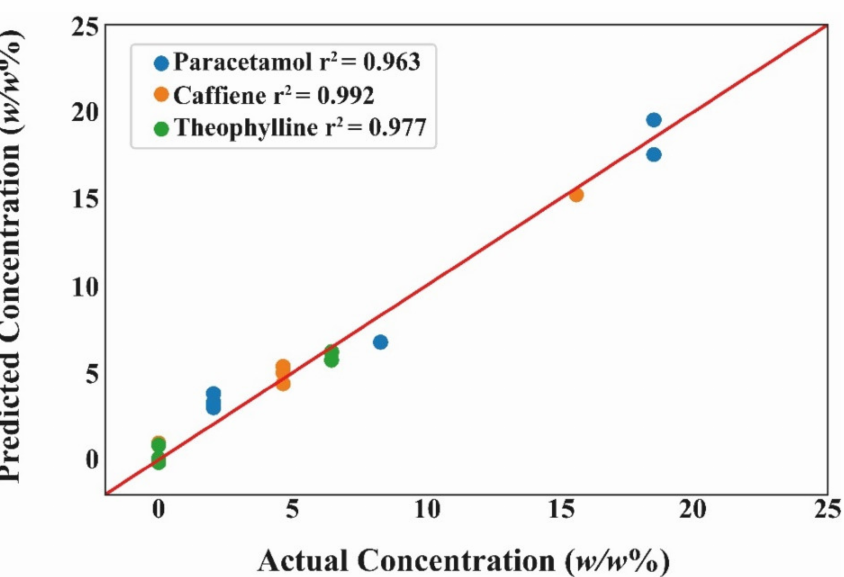
Figure 12. Comparing the predicted to the actual drug concentration on the test dataset for each API. The results are of the pre-processed NIR-ML data using partial least